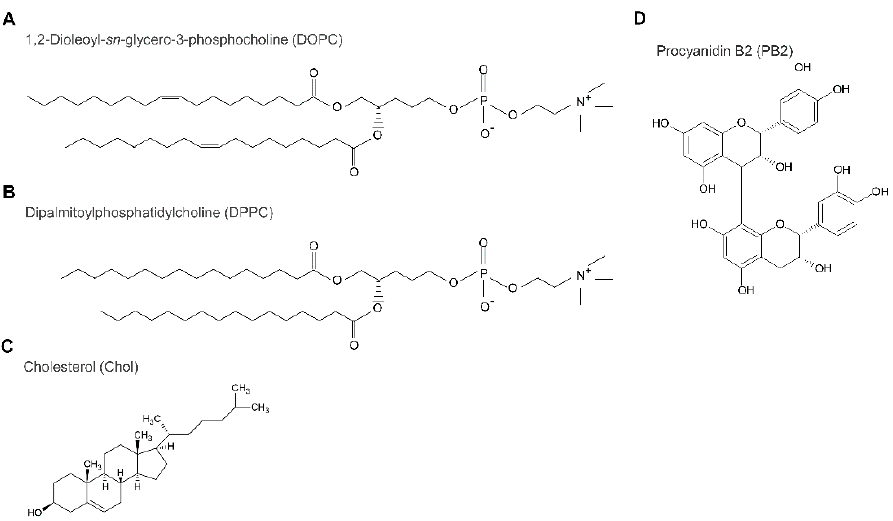
Figure 6. Structure of lipids, cholesterol, and procyanidin b2; 1,2-Dioleoyl-sn-glycero-3- phosphocholine (DOPC; A ), 1,2-dipalmitoyl-sn-glycero-3-phosphocholine (DPPC; B ), cholesterol (Chol; C ), and procyanidin B2 (PB2; D ).